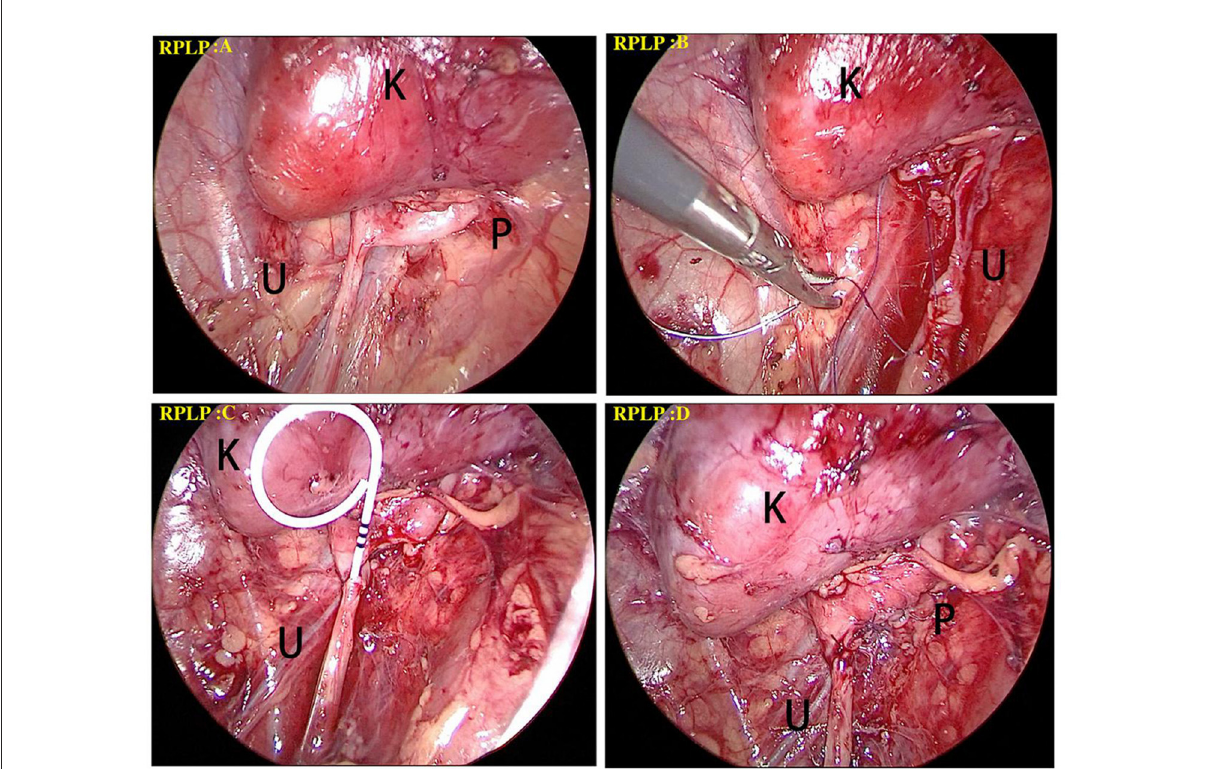
FIGURE1 Surgical procedure of RPLP for the treatment of a left-side UPJO. (A) The perirenal fascia was longitudinally cut to expose the dorsal side of the lower pole of the kidney (black K), followed by separation and exposure of the renal pelvis (black P) and upper ureter (black U) to clarify the location and cause of stenosis. (B) The anastomosis started between the vertex of spatulated ureter (black U) and the most dependent part of renal pelvis. (C) A double J tube was antegradely introduced through the anastomosis. (D) The remainder of anastomosis was